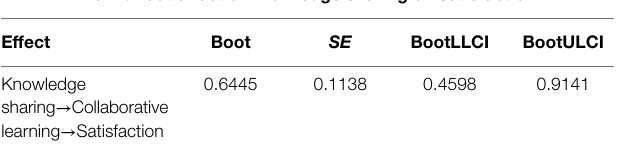
TABLE 4 | Mediating effect of collaborative learning.